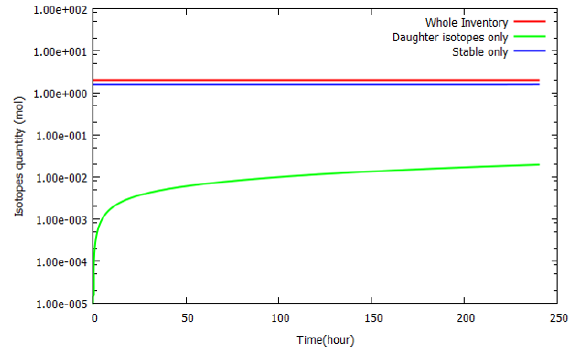
Figure 1. Scheme of the chemical plant